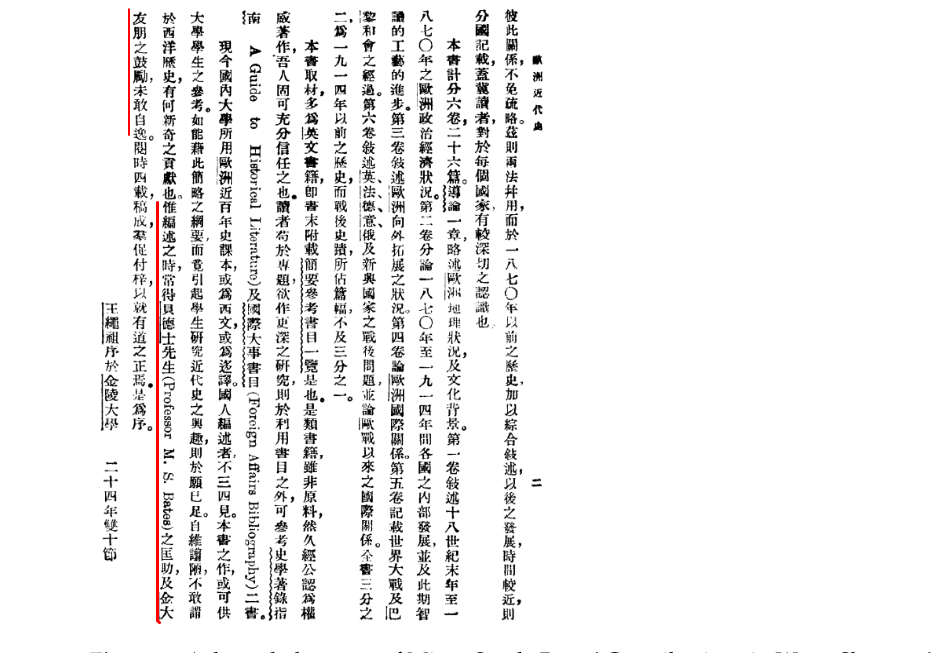
Figure 6. Acknowledgement of Miner Searle Bates’ Contributions in Wang Shengzu’s Foreword in the Book Modern History of Europe.